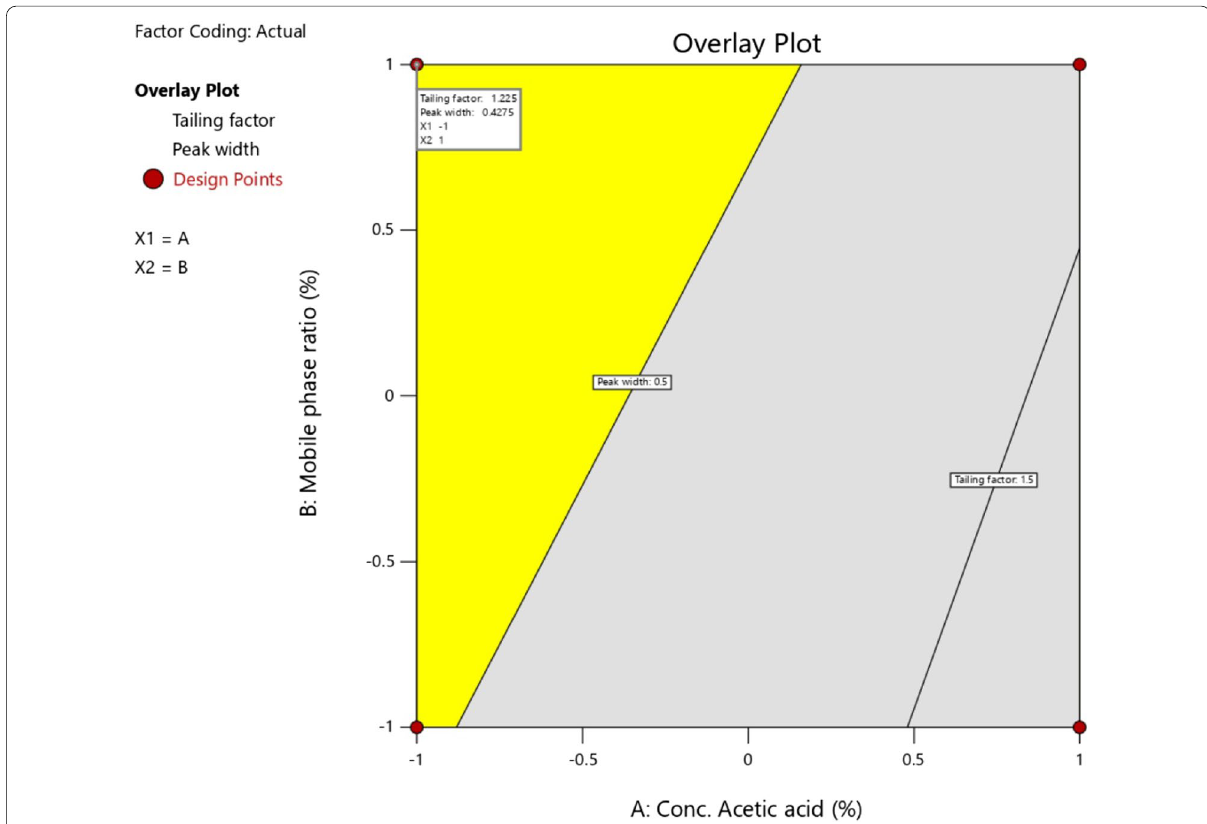
Fig. 3 MODR for optimization of HPLC method for Piperine